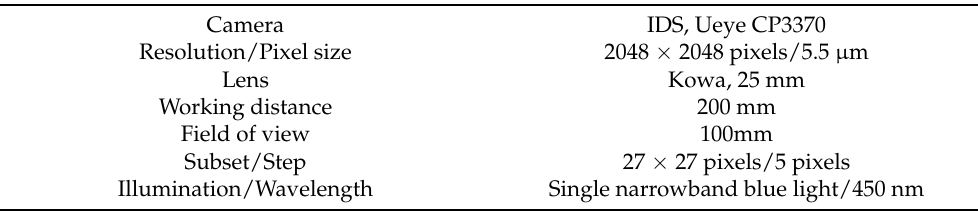
Table 1. System parameters for the experiments.